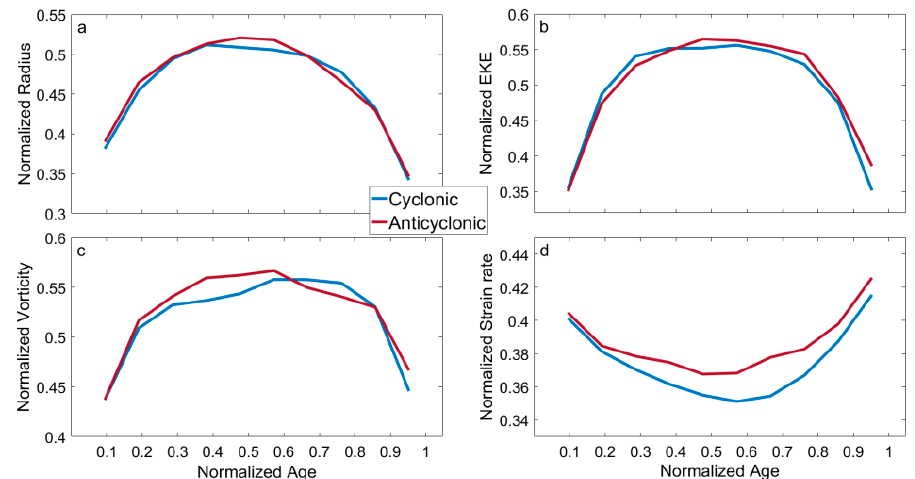
Figure 10. Time evolution of the mean normalized ( a ) radii, ( b ) eddy kinetic energy, ( c ) relative vorticity and ( d ) strain rate.